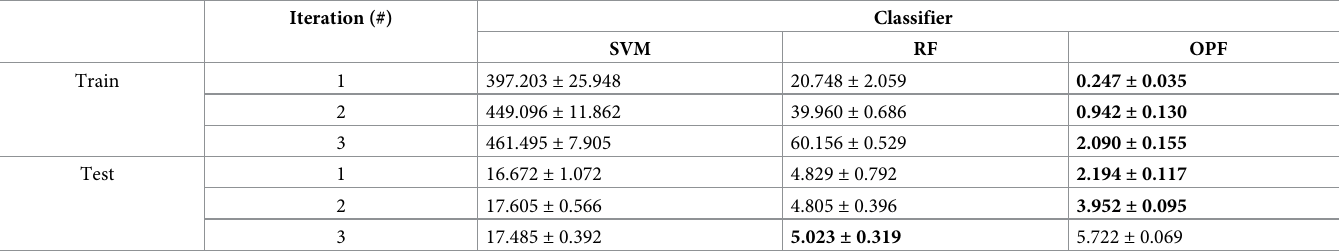
Table 6. Average computational times and standard deviations (in milliseconds) per iteration for the training and testing processes, using the supervised classifiers for the Pl@antLeaves II dataset. The best results (shorter times) are highlighted in bold.